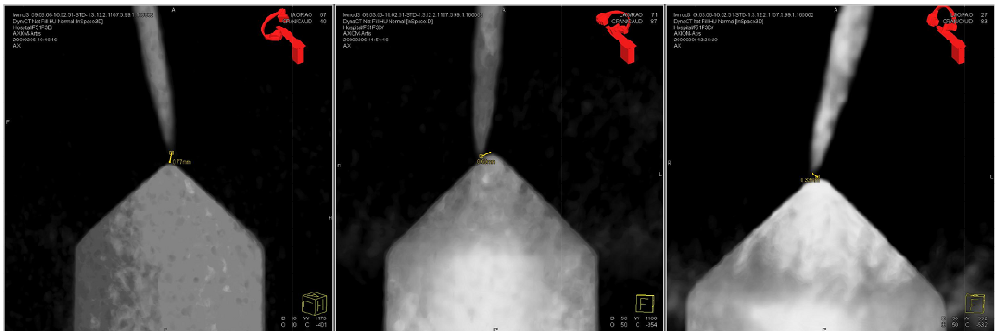
Sensors 201 Figure e 17. The er was de as the frequence distance b between the measu ured on the r reconstructe ed CT-imag ges.